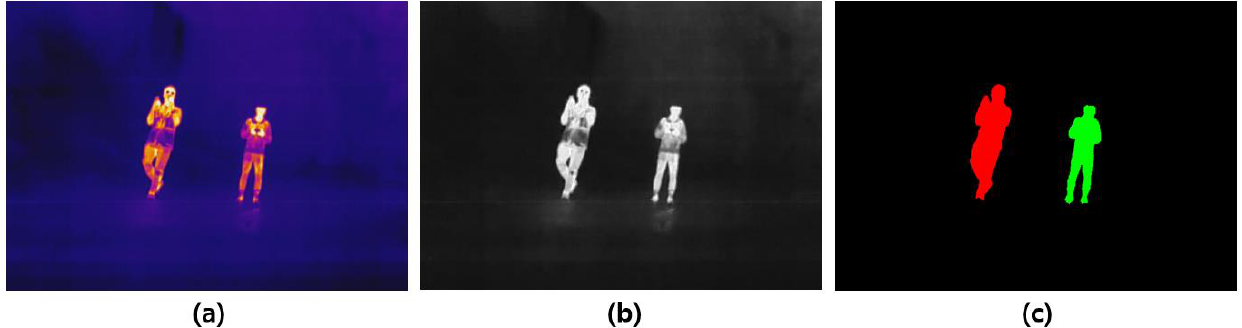
Figure 8. Example of thermal image processing to detect human presence: ( a ) thermal image is obtained; ( b ) it is converted into a grayscale image; ( c ) it is converted into a binary image, and the number of humans is counted.